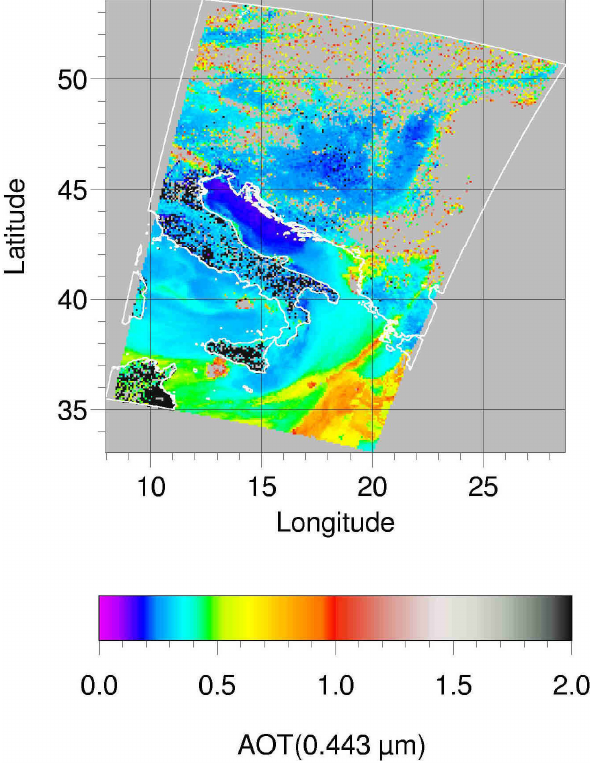
Fig. 12. Smoke plumes of the large forest fires in Greece of summer 2007, MERIS RR scene of 26 August 2007, 09:21UTC. Several forest fires at the Greek and Albanian coasts can be identified and the aerosol transport along the trajectories to the south – west can be observed. Thus satellite observations enable the control of pollution even there, where no direct observations are